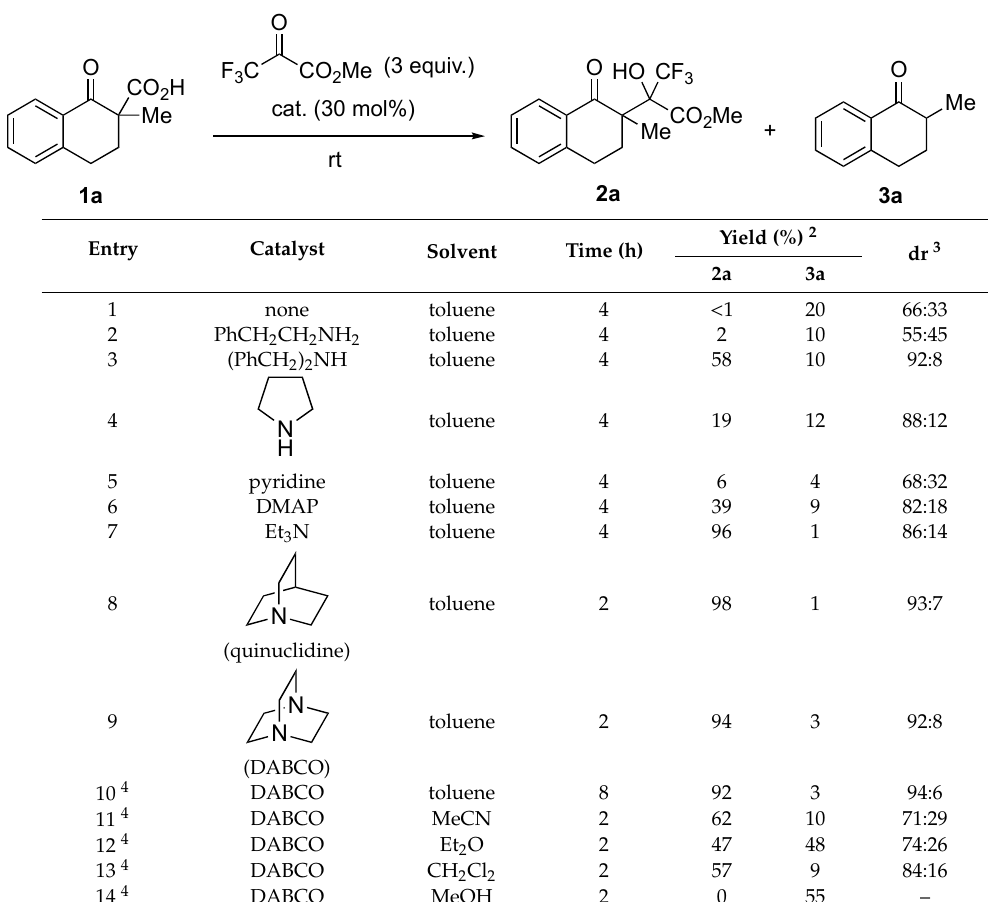
Table 1. Optimization of the amine catalyst 1 .